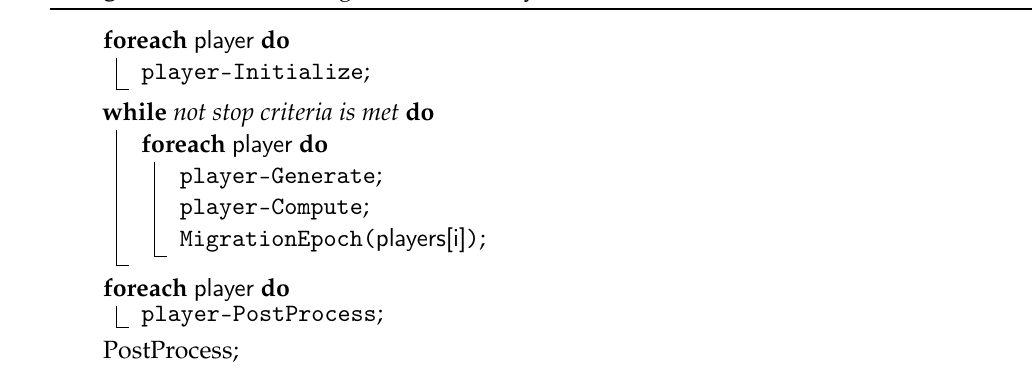
Algorithm 1: General algorithm of the Hybrid